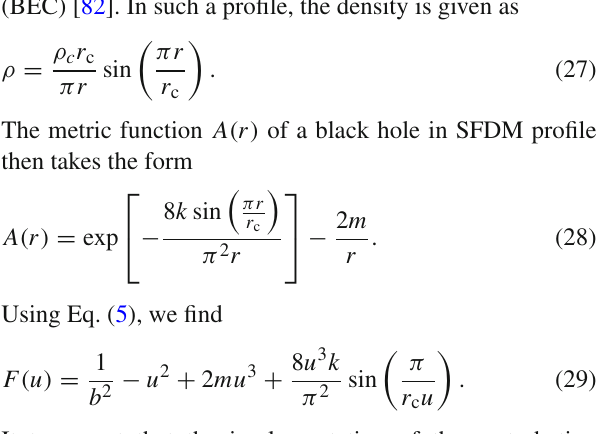
Fig. 3 Curve of the weak deflection angle in the CDM profile for different values of the dimensionless impact parameter b / m in M87. The vertical dotted line is the value of the outermost core radius r c ∼ 4 . 179 × 10 8 m . The region below the dash-dotted vertical line is the cusp region ( ∼ 3 . 214 × 10 6 m